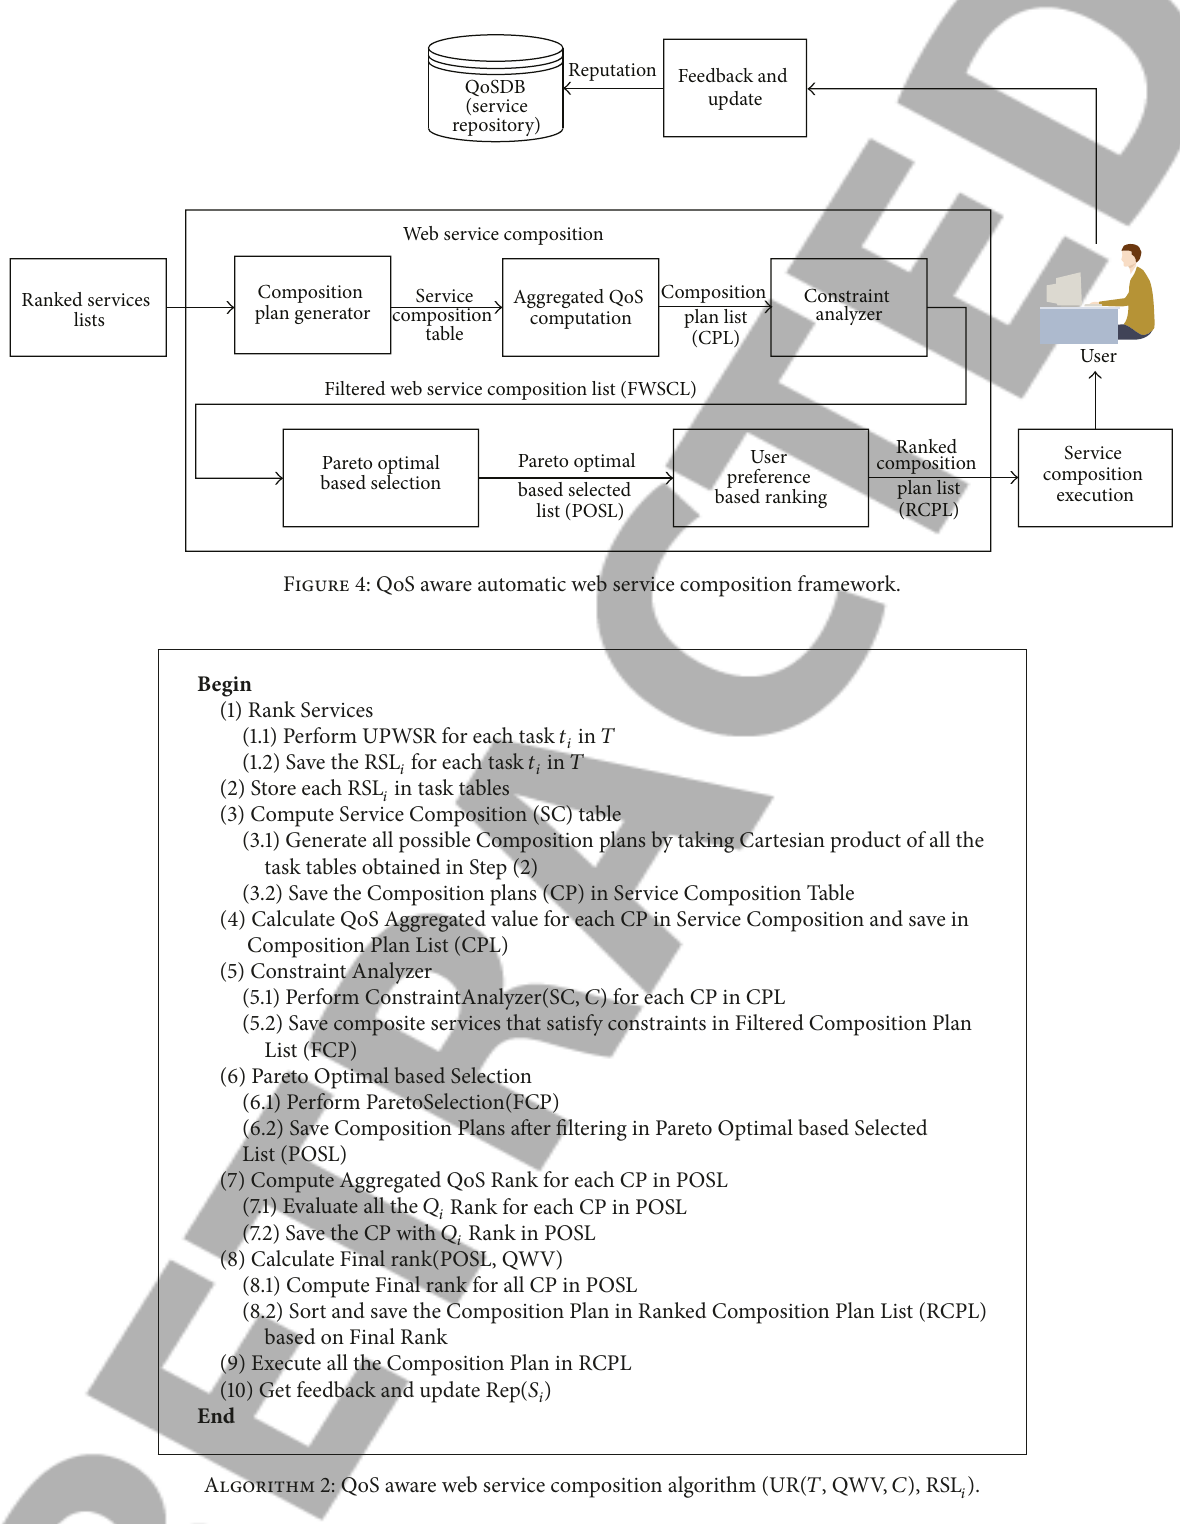
Figure 4: QoS aware automatic web service composition